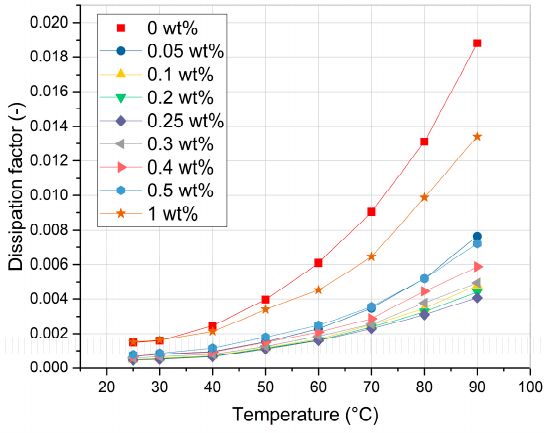
Figure 11. Temperature dependence of the dissipation factor of nanofluids with ST TiO 2 .